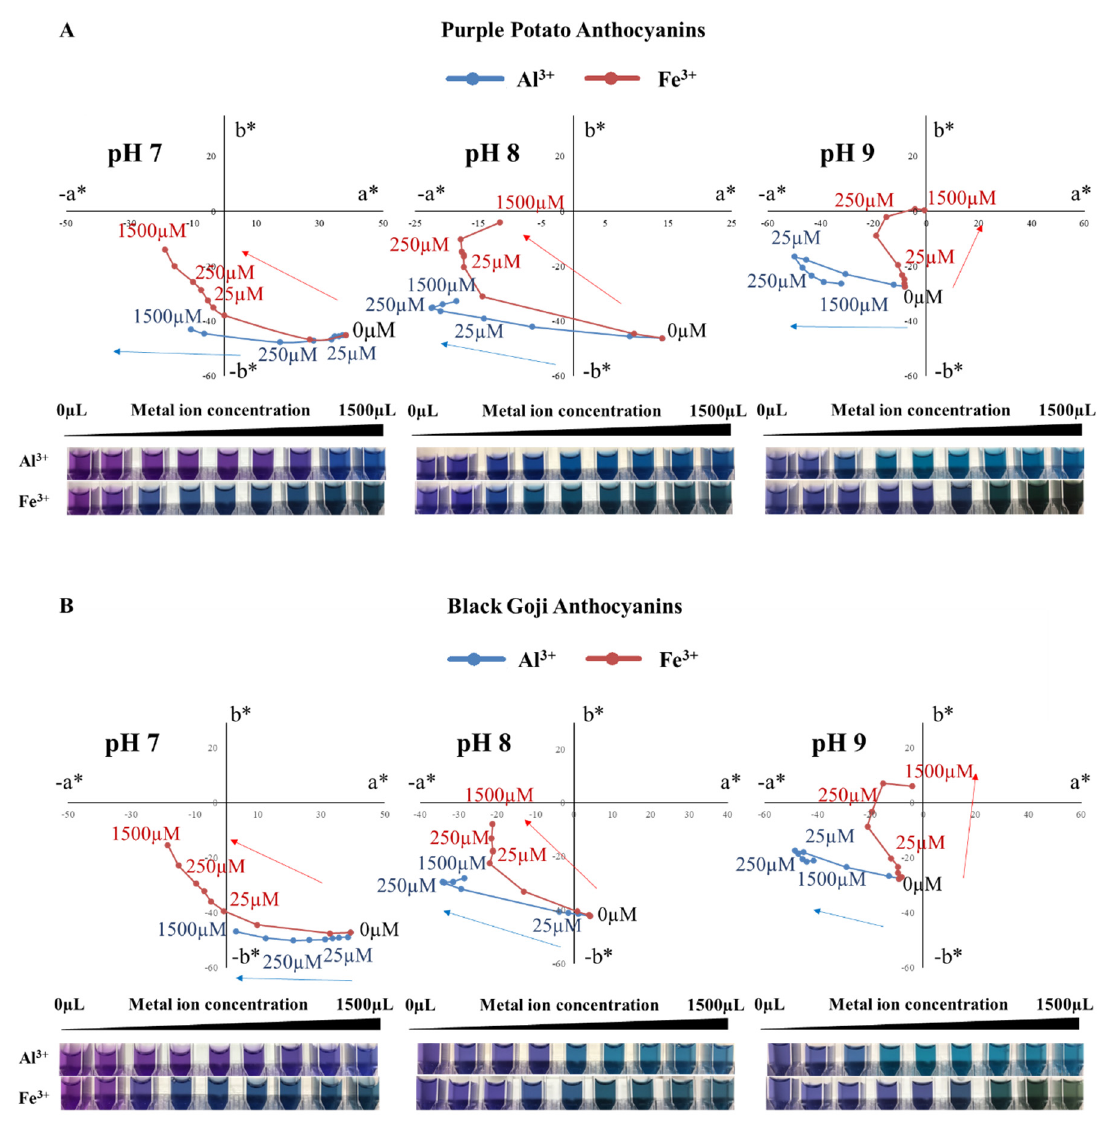
Figure 3. Colorimetric changes of the purple potato ( A ) and black goji ( B ) anthocyanin extracts chelated with metals. Data were collected 1 hr after the anthocyanins were mixed with metal ions and pH adjustment with the buffers.